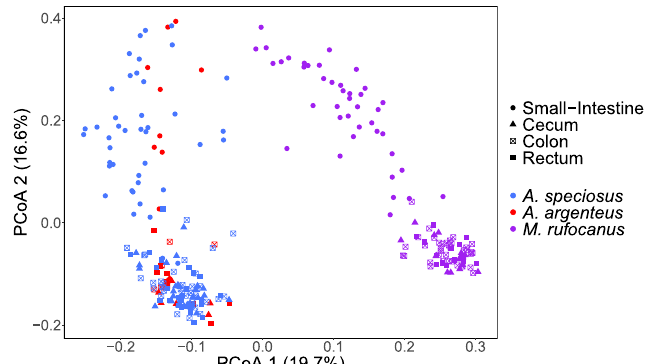
Figure 2. PCoA plot according to unweighted UniFrac in which all samples are plotted. Color indicates host species and shape indicates gut region. The percentages in parenthesis are the proportion of variation explained by the PCoA axis.